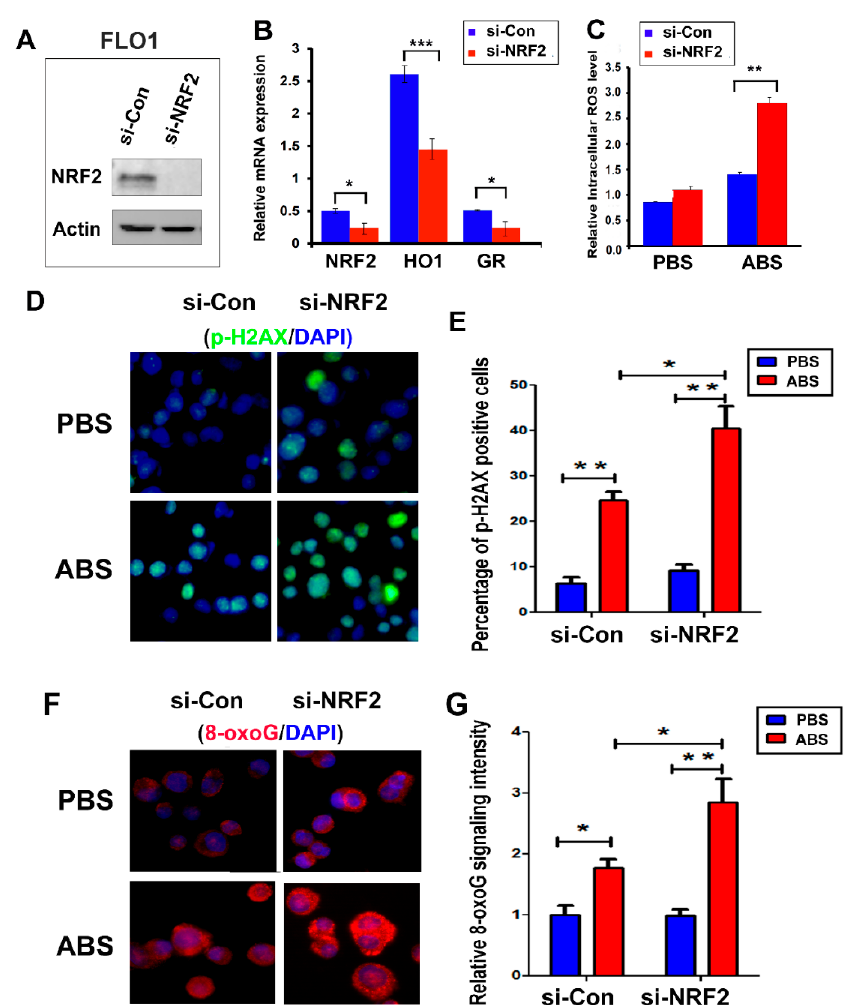
Figure 2. Knockdown of NRF2 expression in EAC cells promoted tumors to ABS-induced double strand break and oxidative DNA damage. ( A ) Western blotting shows the NRF2 level after the knockdown of NRF2 using an NRF2 siRNA in FLO1 cells. ( B ) Real-time RT-PCR shows the downregulation of NRF2 and its downstream target genes, HO1 and GR. ( C ) Knockdown of NRF2 sensitized cells to ABS-induced oxidative stress, indicated as significantly increased intracellular ROS level. ( D , E ) Immunofluorescence staining of γ -H2AX (p-H2AX, S139), a double strand break marker, indicating that knockdown of NRF2 promoted ABS-induced double strand break. ( F , G ) Immunofluorescence staining of 8-oxoguanine (8-oxoG), an oxidative DNA damage marker, indicating that knockdown of NRF2 significantly promoted the ABS-induced oxidative DNA damage level. * p < 0.05; ** p < 0.01; *** p < 0.001.